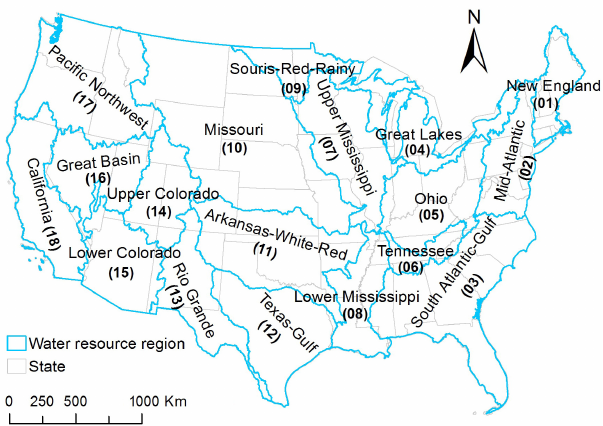
Figure 1. Location of the 18 water resource regions (WRRs) in the conterminous United States